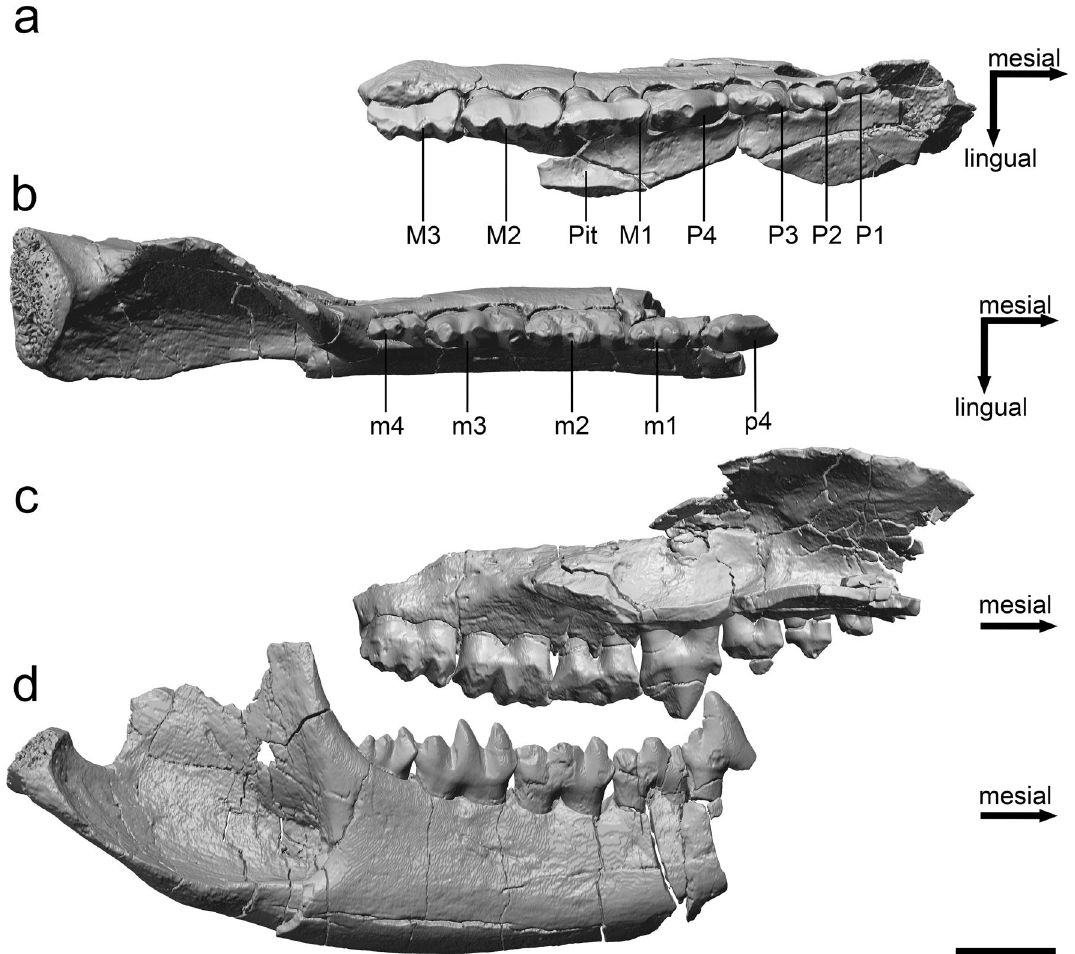
Figure 1. Right dentition of Priacodon fruitaensis (LACM 120451). ( a ) Upper tooth row in occlusal view; ( b ) lower tooth row in occlusal view; ( c ) upper tooth row in lingual view (mirrored for better comparison); ( d ) lower tooth row in buccal view. Note that parts of the palatine have been digitally removed for better visibility and that p4 was repositioned in the virtual model to its natural position because it was damaged and shifted upwards during fossilization. The posterior part of the jaw, beginning with the ascending ramus, was shifted laterally due to damage and the masseteric fossa, therefore, appears larger in occlusal view. Scale bar equals 2.5